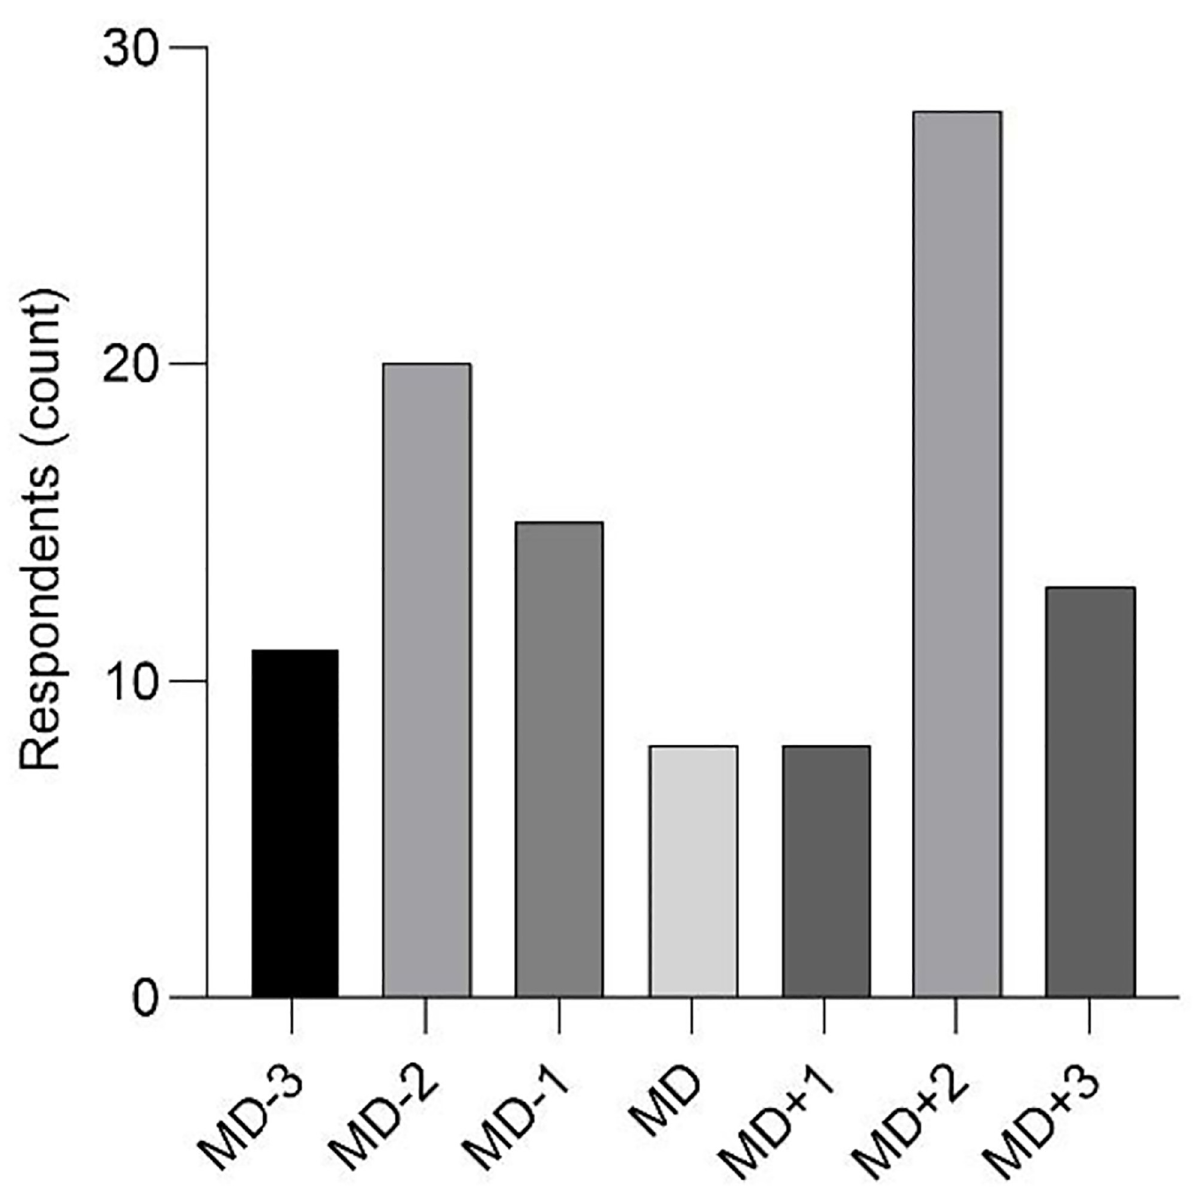
Fig 3. Count of SME who responded to “On what days relative to the match-day (MD) , do you (or would you) consider it important to monitor to monitor the athlete’s fatigue state ? ” . The SME were free to select more than one selection if they considered it important.